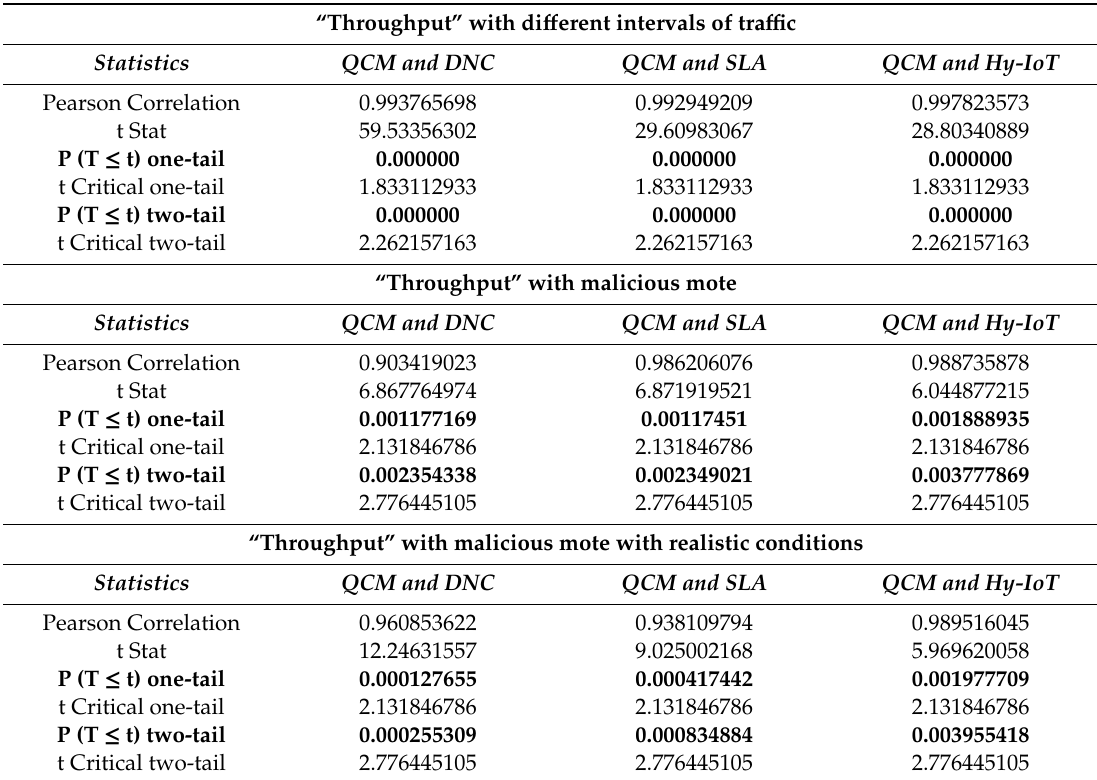
Table 6. Inferential analysis of the proposed QCM algorithm in terms of “Throughput” scenarios. “Throughput” with di ff erent intervals of tra ffi c